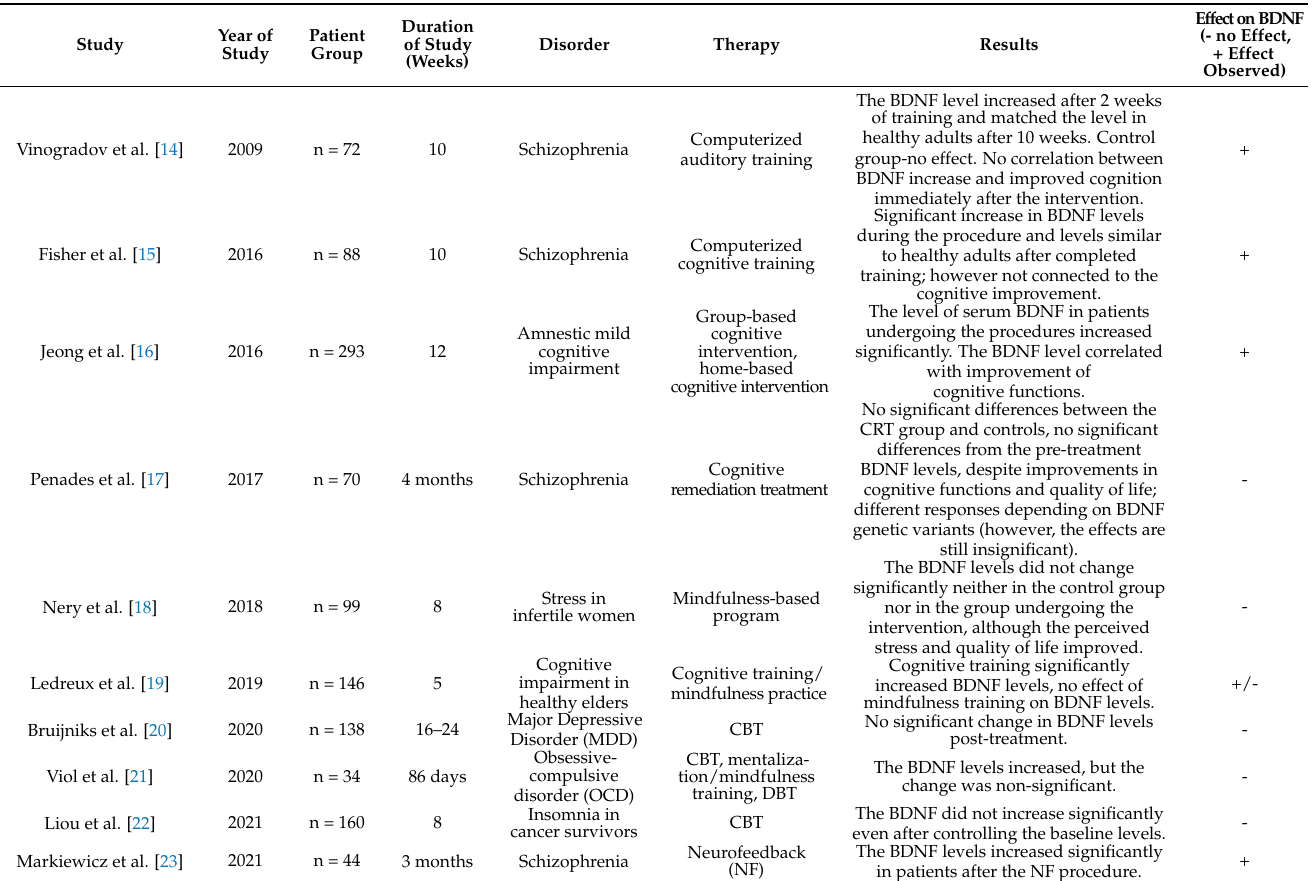
Table 2. Summary of the papers